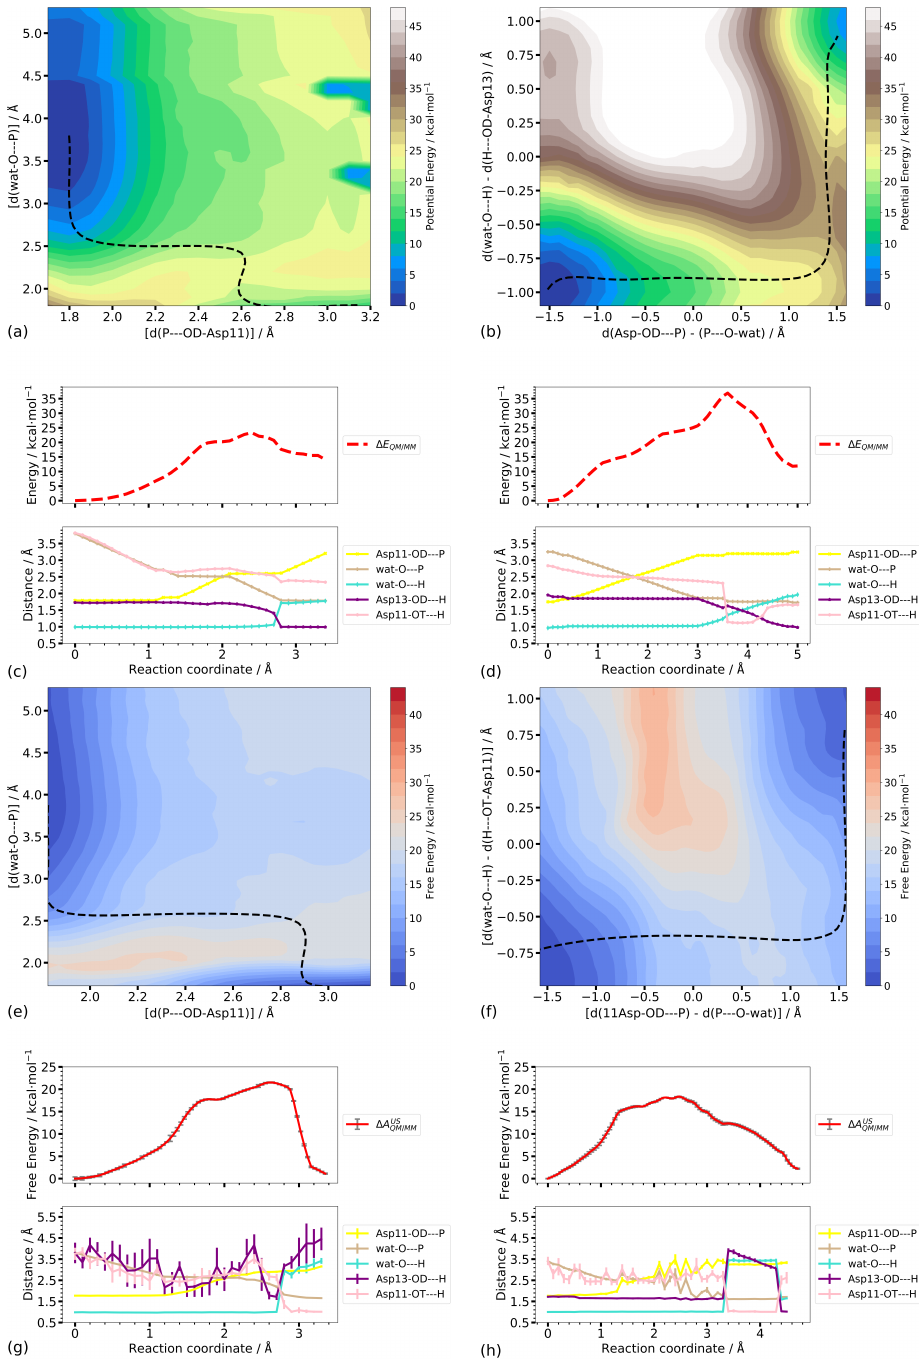
Figure 11. ( a , b ) Two-dimensional potential energy surfaces of Step 2. The dashed lines indicate the minimum energy pathway. ( c , d ) Energy profiles of the minimum energy paths in Step 2 (top) together with important distances (bottom). The reaction coordinate is the accumulated path lengths. ( e , f ) Two-dimensional free energy surfaces from umbrella sampling. The dashed lines indicate the minimum free energy pathways. ( g , h ) Free energy profile (top) together with important distances (bottom). The reaction coordinate is the accumulated path